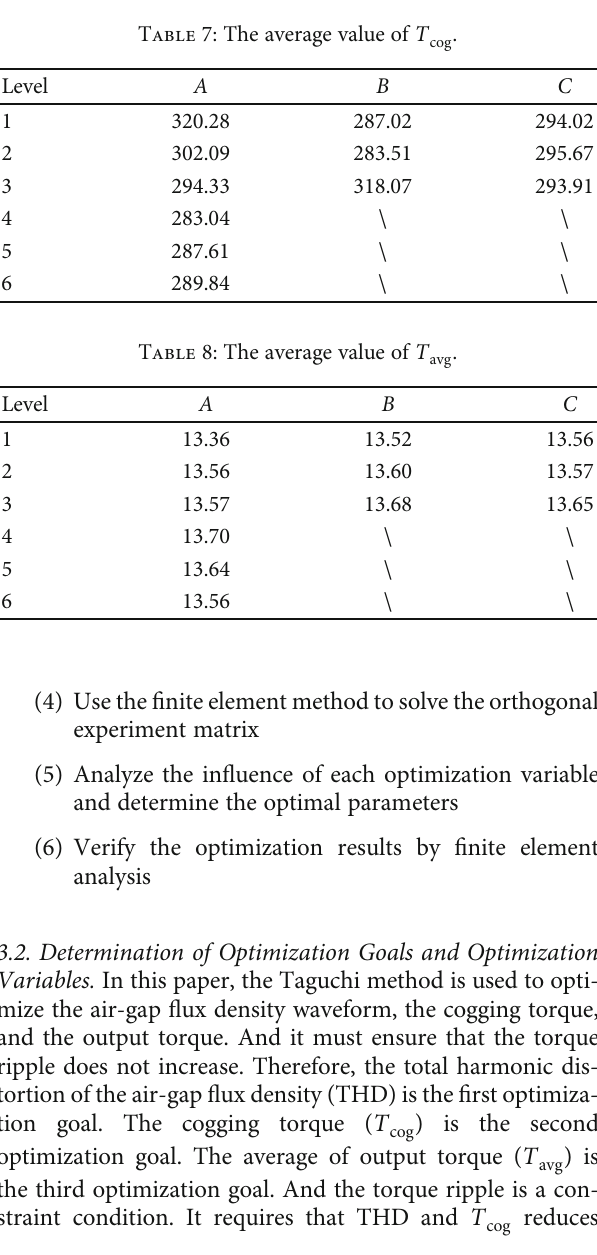
Table 7: The average value of T